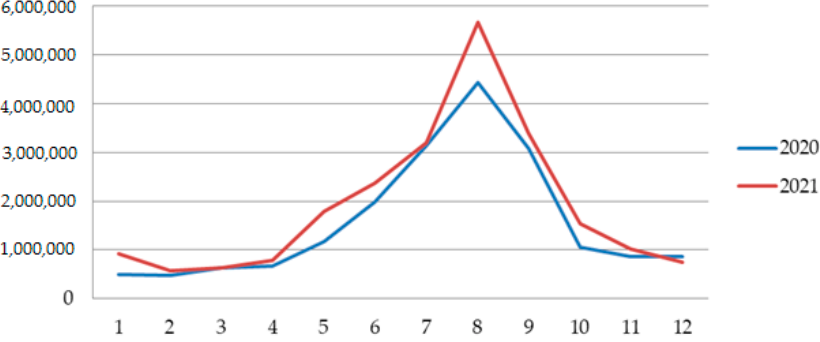
Figure 9. The phytoplankton abundance in Aleksandrovac Lake during 12 months in 2020 and 2021.